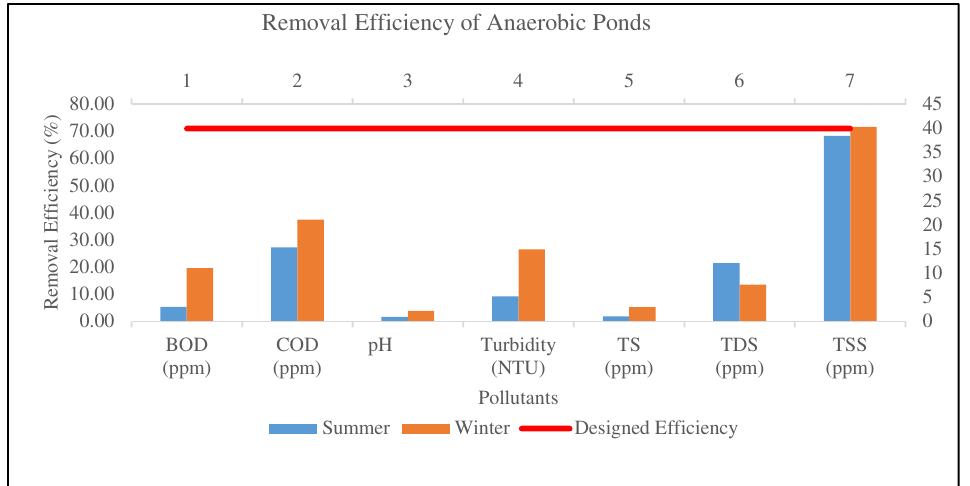
Fig. 2: Removal Efficiency of Anaerobic Ponds in Removing Selected Parameters